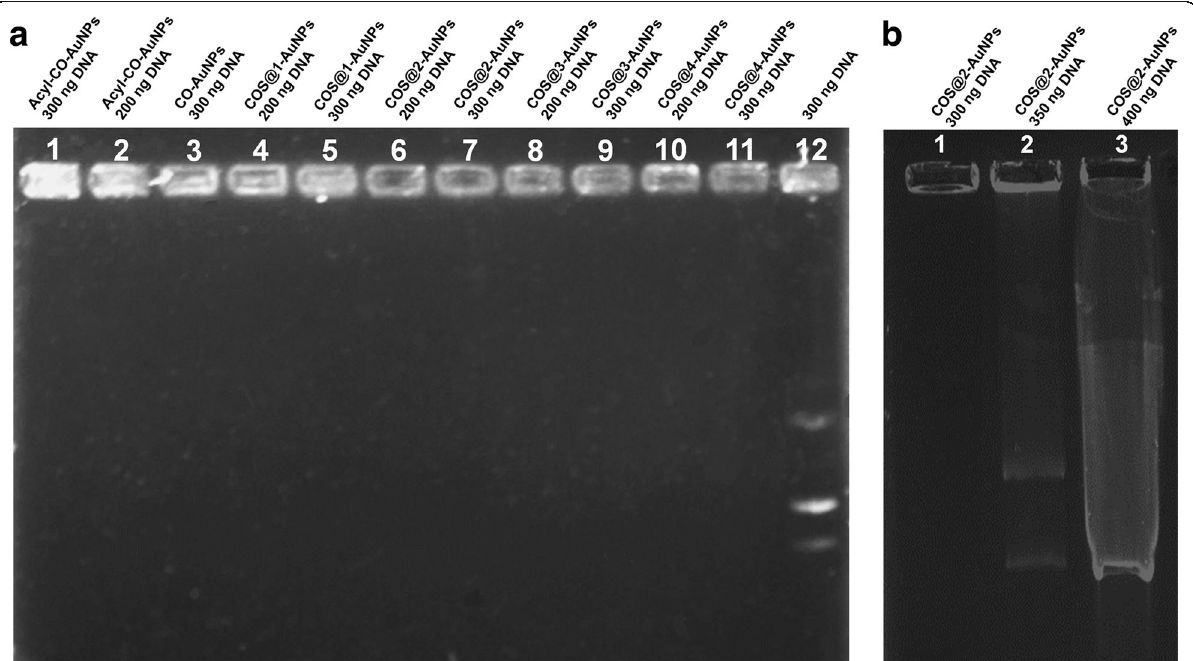
Fig. 7 a Electropherograms for nanocomplexes with 200 and 300 ng pDNA concentrations. Lane 12 corresponds to pure pDNA. b CO-AuNPs and Acyl-CO-AuNPs with 300 ng of pDNA, pure pDNA at lane 3. c COS@2-AuNPs nanocomplex with 300 and 350 ng of DNA, 400 ng of pure pDNA at lane 3. d same CO-AuNPs and Acyl-CO-AuNPs at 1:10 dilution, with respectively pure DNA control at lane